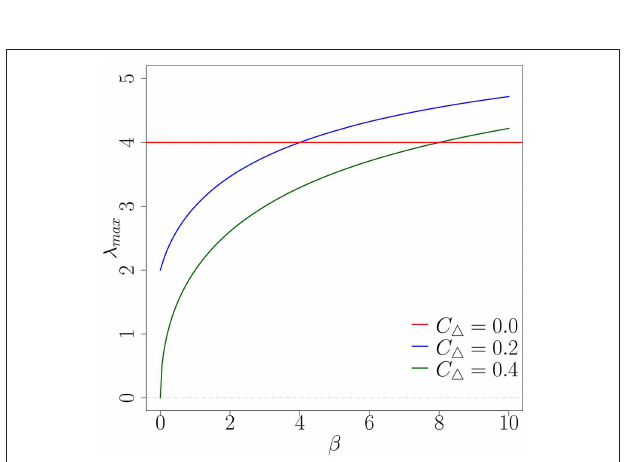
FIGURE 7 | Comparison of λ max for varying β on the three network topologies. The largest eigenvalues for the moderately clustered network (blue) and the highly clustered network (green) intercept the random case (red) at β 4 and β 8 , = =